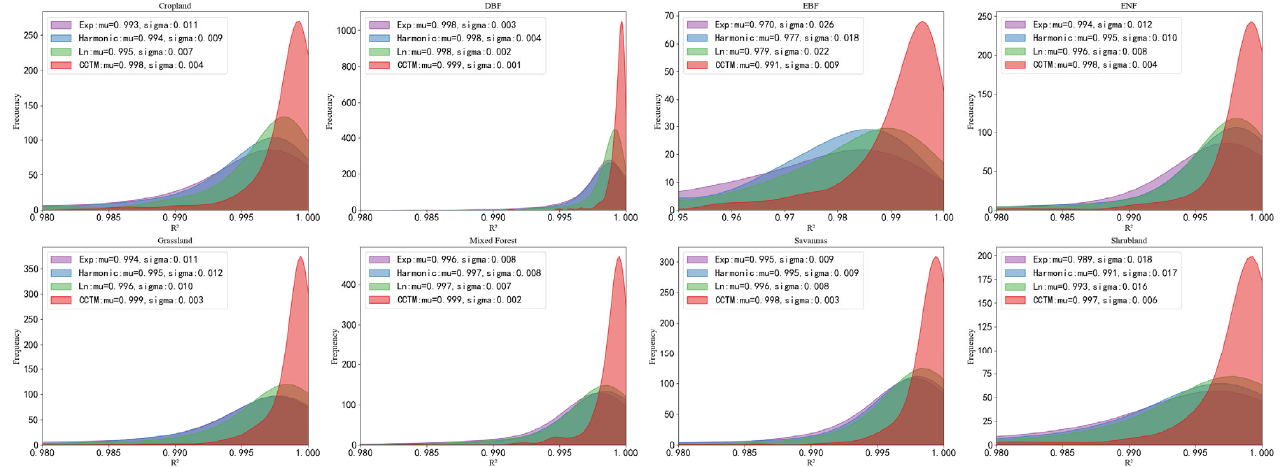
Figure 9. R 2 probability distribution of reconstructed NDVI time-series data after smoothing for different landcover types. The frequency is the number of time series points in a certain RMSE range, and different landcover types may have different RMSE categories.